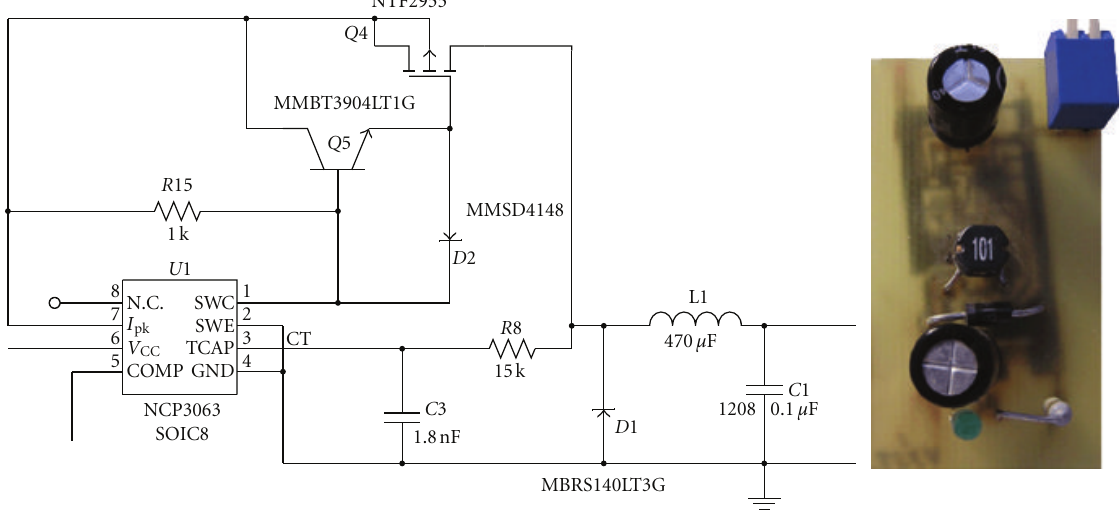
Figure 11: Designed DC-DC converter for wireless module power supply.